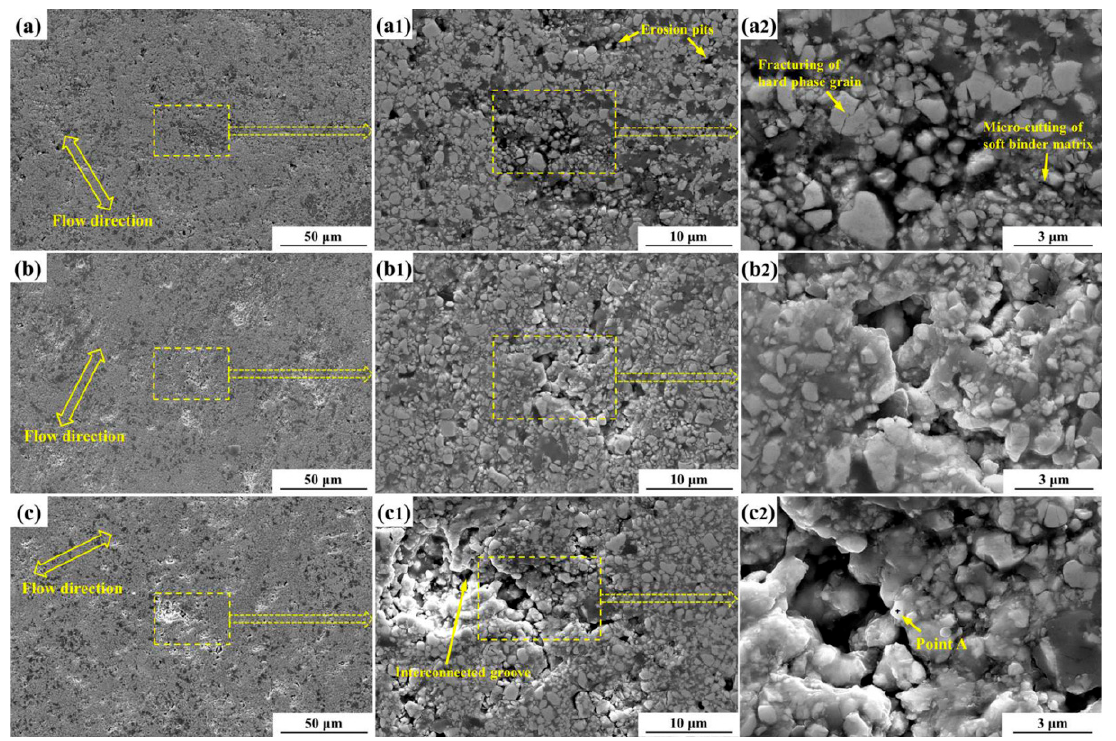
Figure 4. FE-SEM images of the WC-Cr 3 C 2 -Ni coatings after HAE for 6 h in 3.5 wt.% NaCl aqueous solution at 20 kg·m − 3 and different FVs: ( a ) 23.4 m·s − 1 ; ( a1 ) a magnification of the rectangular frame in ( a ); ( a2 ) a magnification of the rectangular frame in ( a1 ); ( b ) 33.5 m·s − 1 ; ( b1 ) a magnification of the rectangular frame in ( b ); ( b2 ) a magnification of the rectangular frame in ( b1 ); ( c ) 41.9 m·s − 1 ; ( c1 ) a